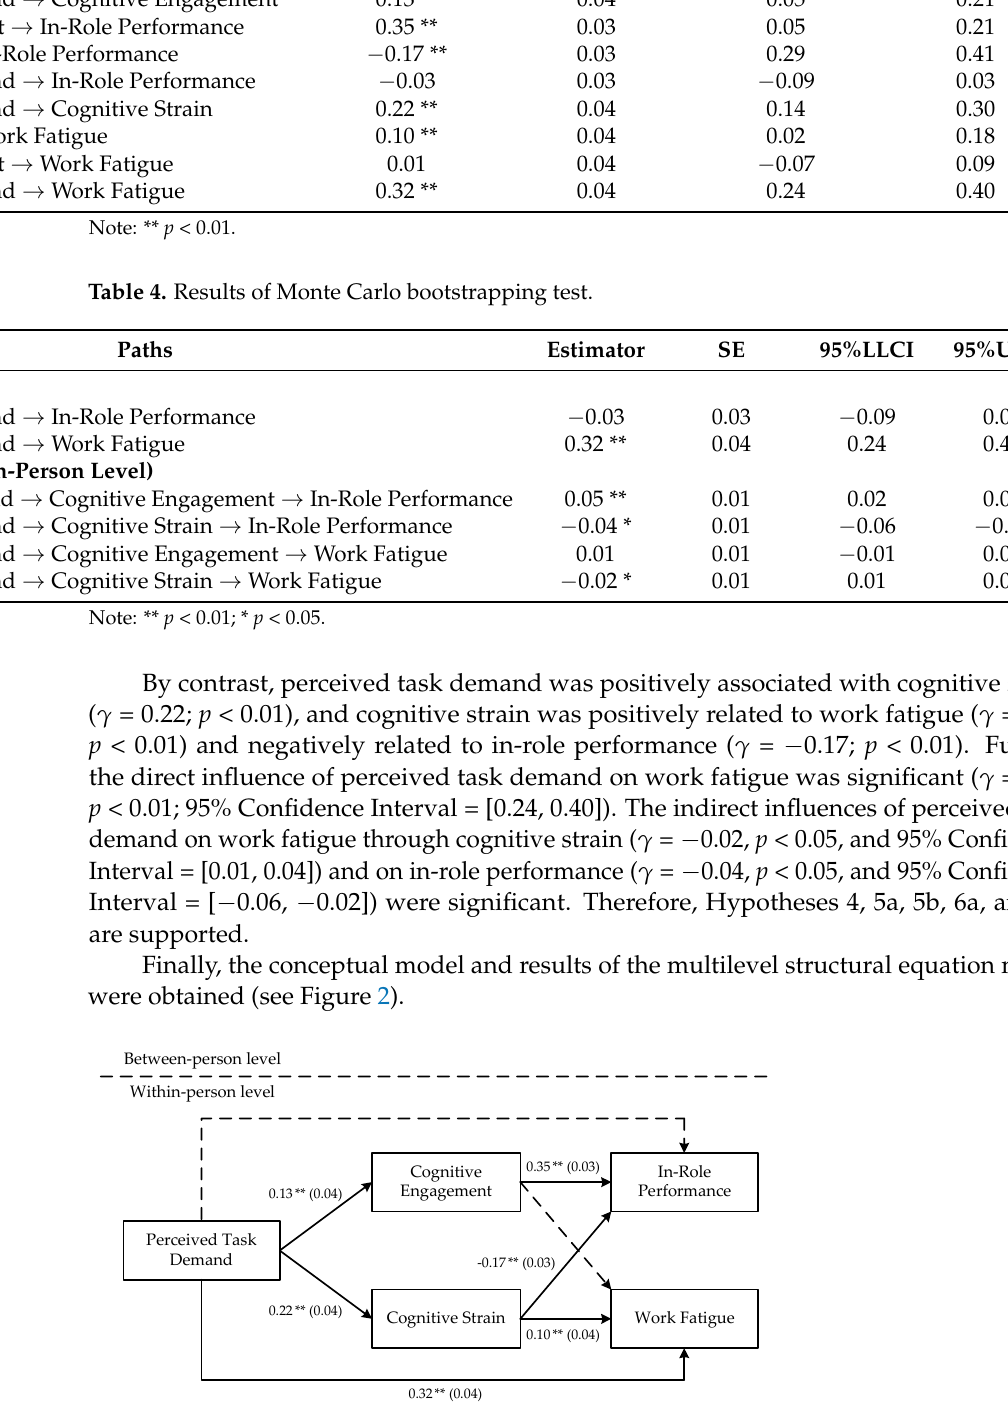
Figure 2. Conceptual model and results of multilevel structural equation modeling. Notes: values in parenthesis are standard errors; parameters are unstandardized; ** p <